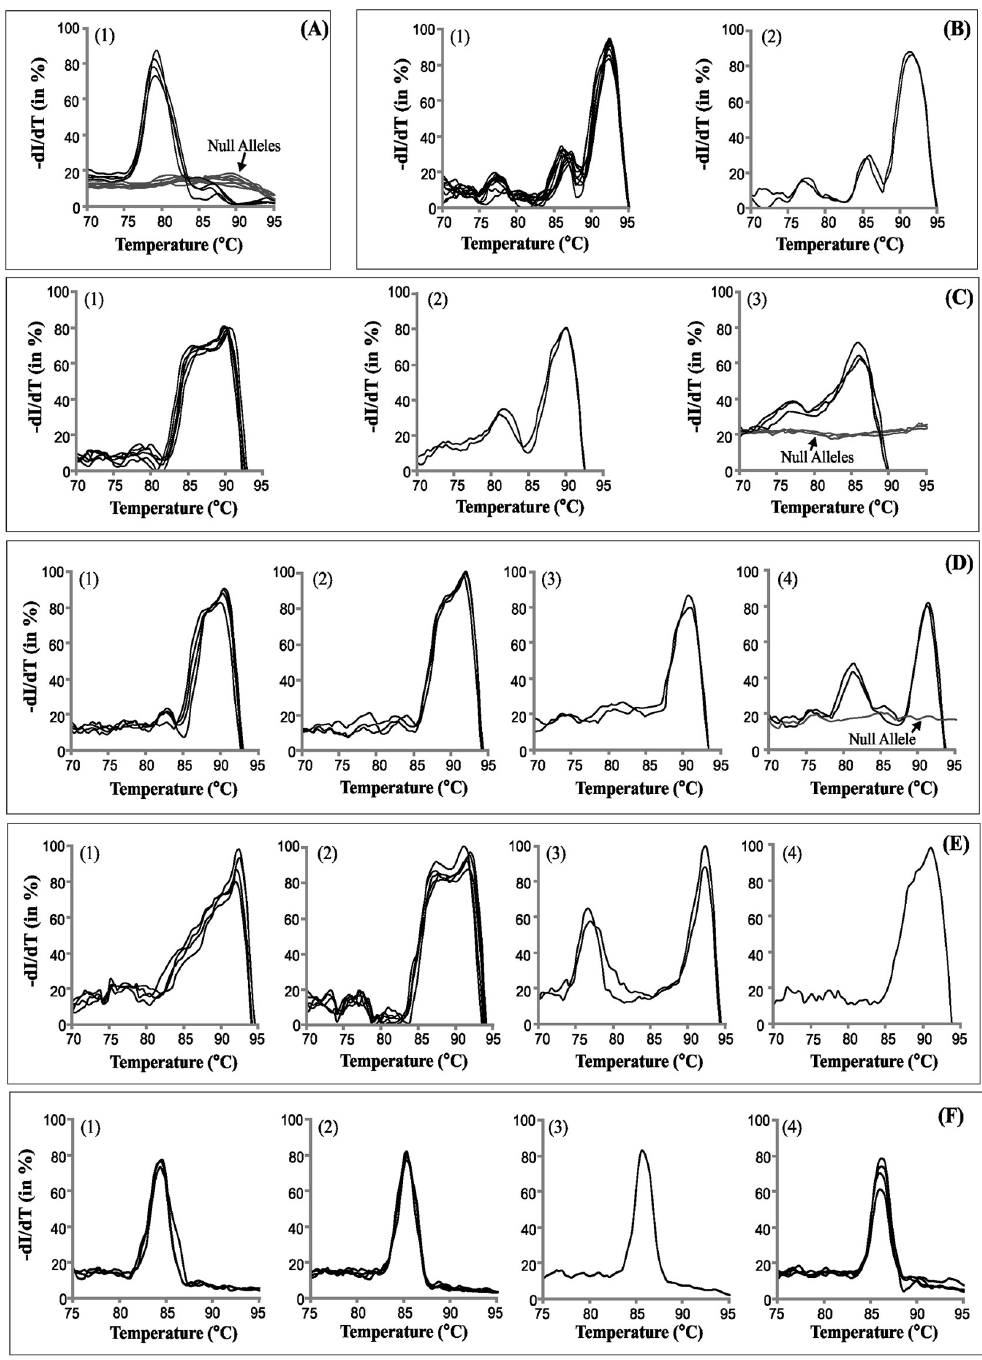
Fig 4. STMS allele differentiation by SYBR Green melt-profiling. S YBR Green melt-profiles of alleles of STMS markers among twelve wheat (A-E) and rice (F) genotypes: A) wheat STMS Xgwm 162–3A, B) wheat STMS Xgwm 304–5A, C) wheat STMS Xgwm 169–6A, D) wheat STMS Xgwm 282–7A, E) wheat STMS Xgwm 448–2A, and F) rice STMS RM 447. Multiple melt-profiles of STMS marker alleles (indicative of variation in Tm and curve shape difference) are indicated by number (1–4) while null alleles (if any) are indicated by